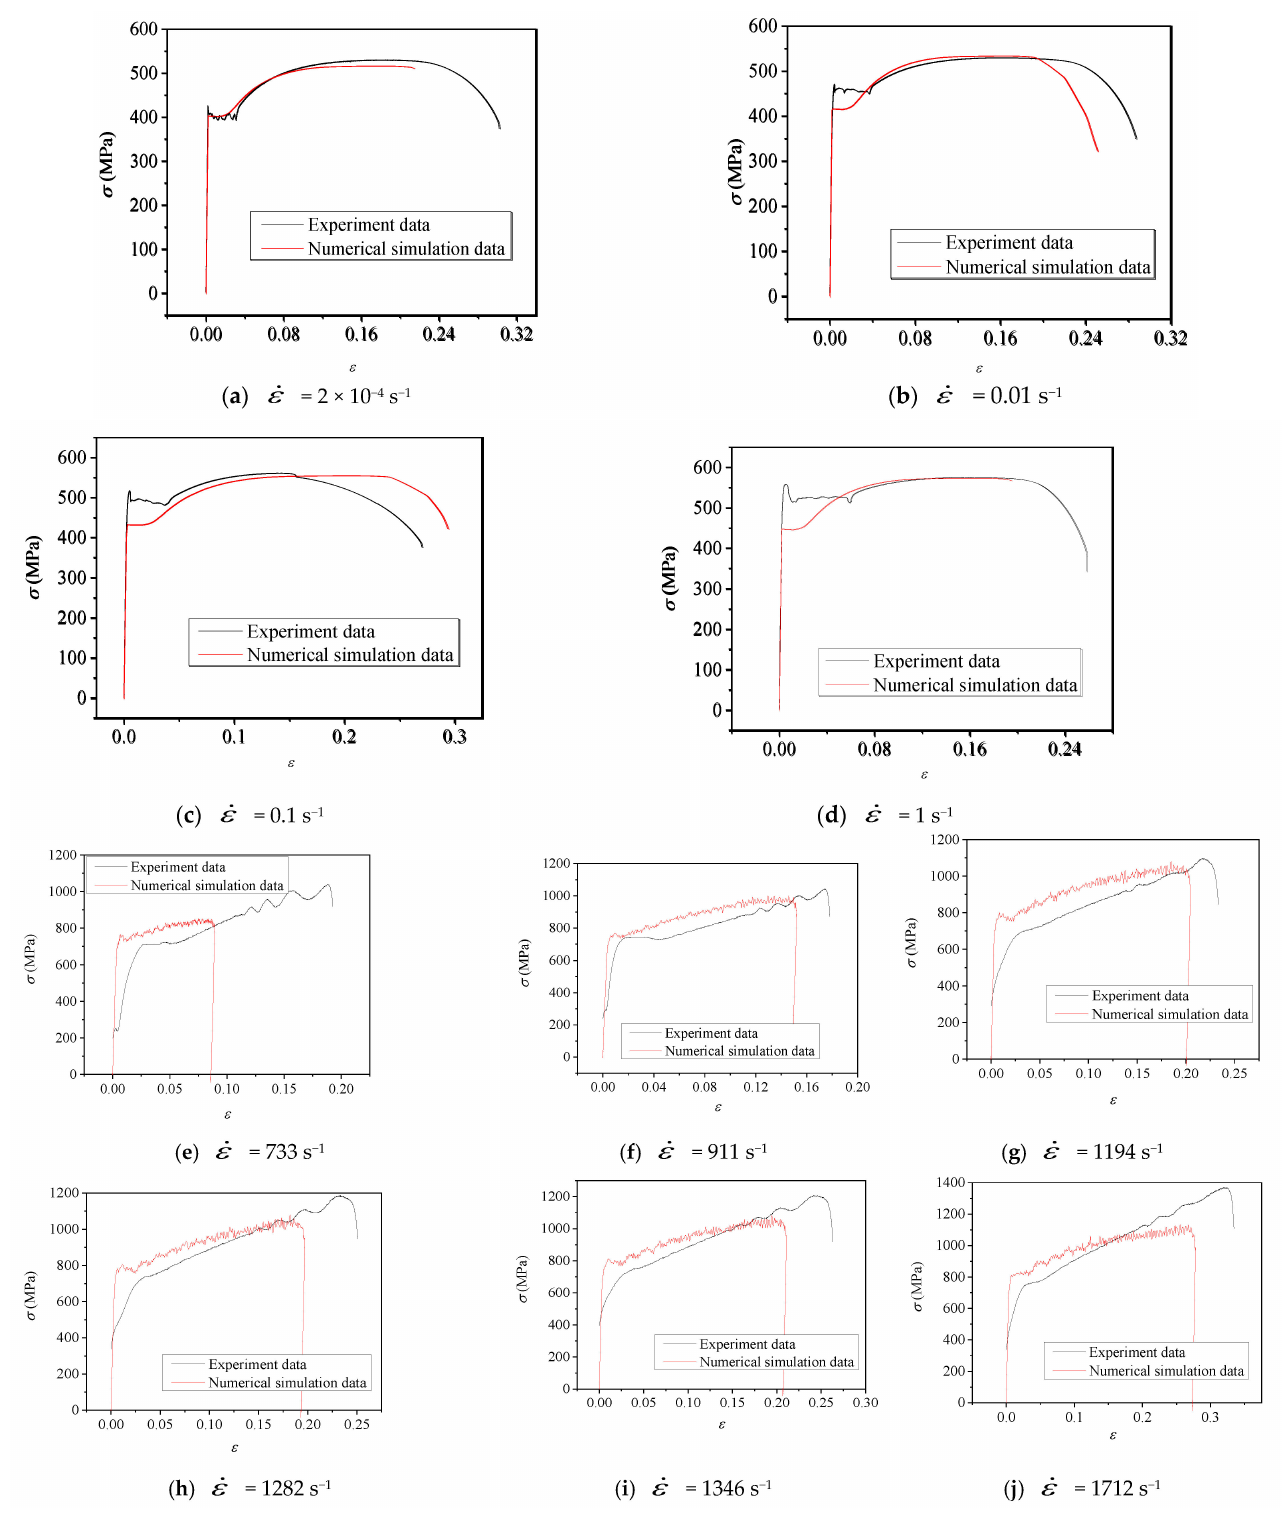
Figure 17. Comparison of the test and the numerical results of C = 2639.4, P =